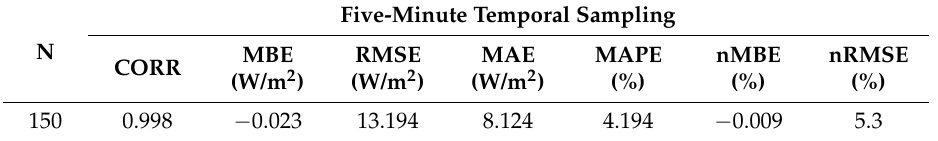
Table 7. Statistical analysis for the five-minute AMESIS temporal sampling product against ground measurements at the IMAA/CNR—Tito site, considering the whole dataset. N = the total number of hourly mean irradiance values.